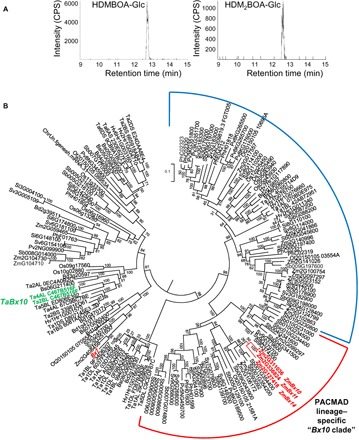
Identification and characterization of TaBX10 as a functional DIMBOA-Glc OMT.(A) Recombinant TaBX10 methylates DIMBOA-Glc and DIM2BOA-Glc. The enzyme was heterologously expressed in E. coli, purified, and incubated with a mixture of DIMBOA-Glc and DIM2BOA-Glc. Enzyme products were analyzed using liquid chromatography–tandem mass spectrometry (LC-MS/MS). CPS, counts per second (electron multiplier). (B) Phylogenetic tree of Poaceae OMT genes similar to Bx7. Maize Bx7,10,11,14 and wheat TaBx10 are shown in red and green, respectively. The tree represents a subclade of a larger Poaceae OMT tree that is given in fig. S13. The tree was inferred by using the maximum likelihood method based on the Tamura 3-parameter model. Bootstrap values are shown next to each node. The tree is drawn to scale, with branch lengths measured in the number of substitutions per site. Zm, Zea mays; Sb, Sorghum bicolor; Sv, Setaria viridis; Si, S. italica; Pv, Panicum virgatum; Ph, P. hallii; Ot, Oropetium thomaeum; Ta, T. aestivum; Hv, Hordeum vulgare; Bd, Brachypodium distachyon; Bs, B. stacei; Os, Oryza sativa. The PACMAD lineage–specific Bx10 clade is marked in red, and its sister clade is marked in blue.